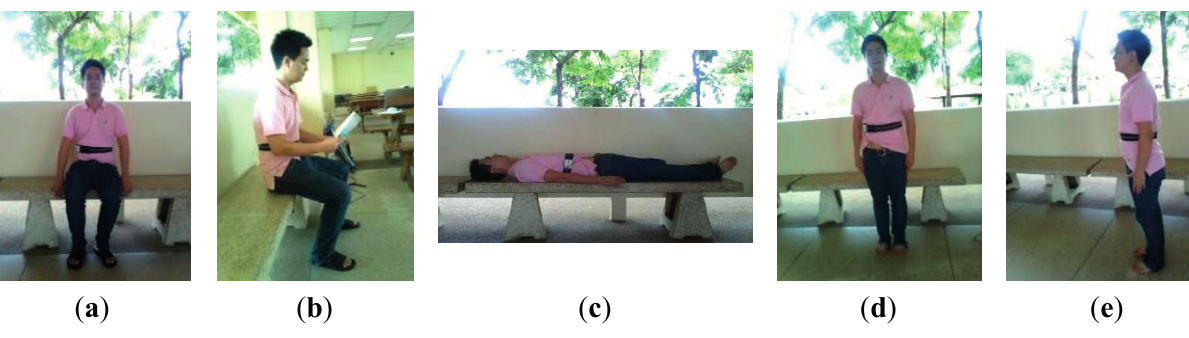
Figure 1. A BSN node with ECG and 3D acceleration sensors attached to a human body.